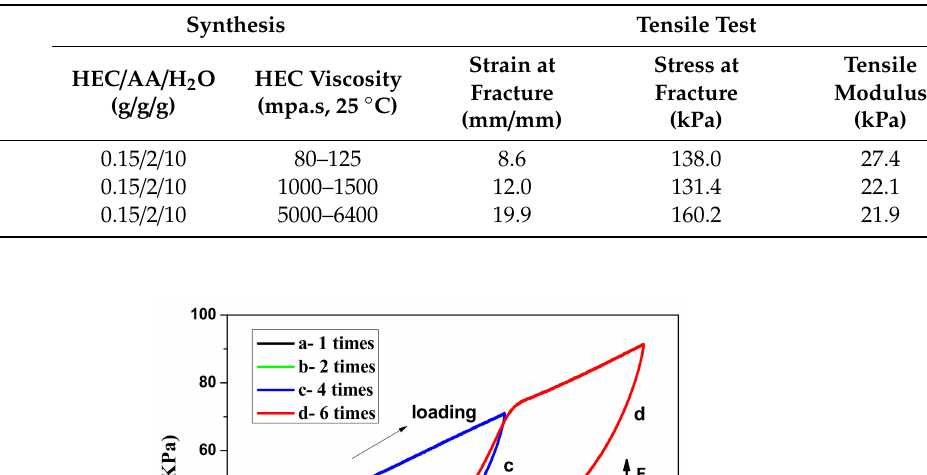
Table 2. The tensile properties of the Agar / PAA / HEC DN hydrogels with di ff erent HEC viscosity.